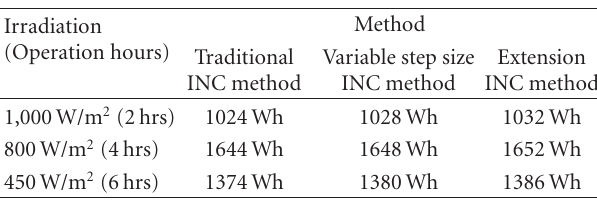
Table 5: Output energy during di ff erent hours of operation using various MPPT methods under three types of single day irradiation.